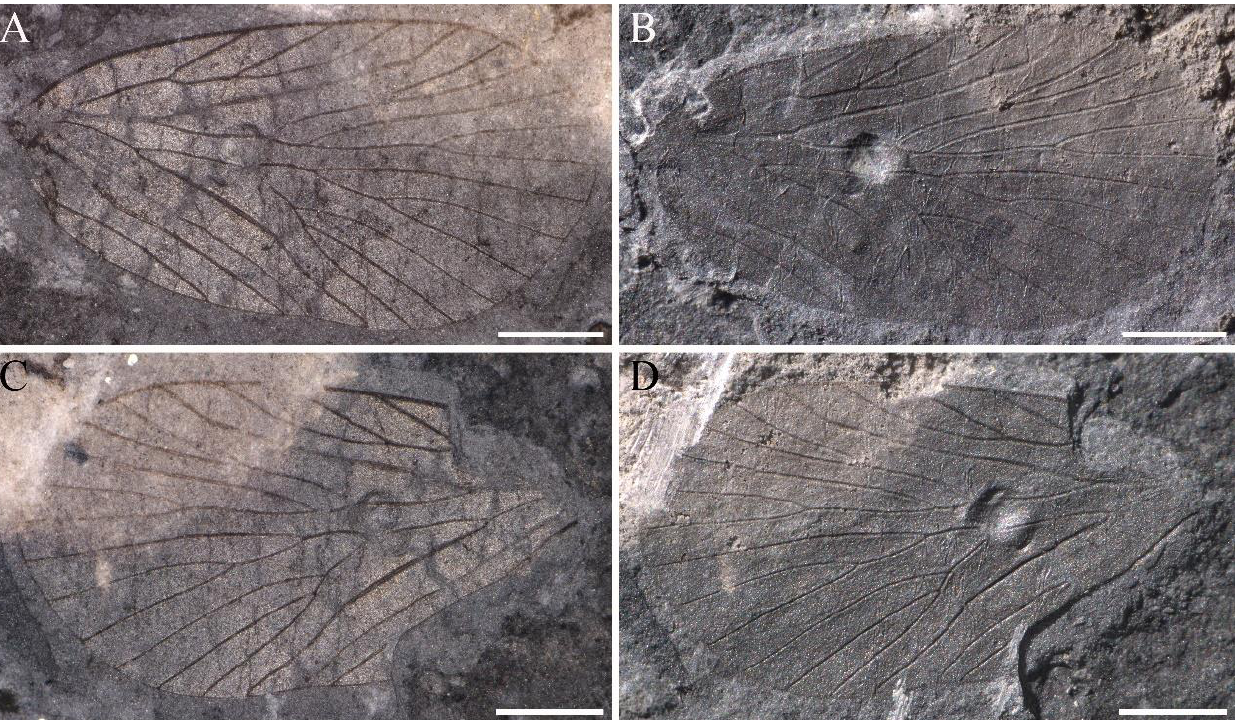
Figure 4. Sinoagetopanorpa nigra sp. nov., NIGP200912 (holotype). ( A , B ) Photographs of part; ( C , D ) Photographs of counterpart; ( A , C ) were taken when specimens were immersed under 70% alcohol in vertical reflected light; ( B , D ) were taken in oblique reflected light. Scale bars represent 1 mm in ( A – D ).